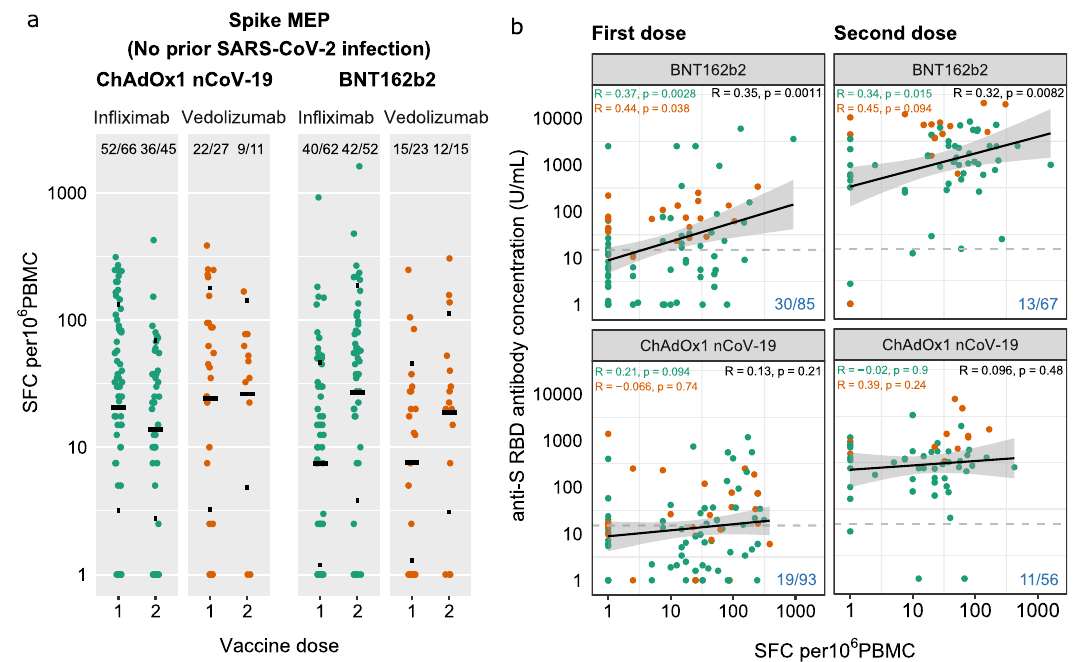
Fig. 3 Anti-SARS-CoV-2 spike T cell responses strati fi ed by vaccine platform (BNT162b2 vs ChAdOx1 nCoV-19), biologic therapy (in fl iximab vs vedolizumab) and vaccine dose (one vs two). a Spike MEP T cell responses SFC per 10 6 PBMC strati fi ed by vaccine platform, biologic therapy (in fl iximab vs vedolizumab) and the number of vaccine doses. The horizontal bar represents the geometric mean and the narrow bars represent one geometric standard deviation on either side of the geometric mean. The number of T cell responders / total number of individuals tested are shown in black at the top of each panel. b Scatterplot demonstrating the correlation between T cell responses against spike MEP pool (SFC per 10 6 PBMC) and anti-SARS-CoV-2 spike antibody concentration after the fi rst (LHS) and second (RHS) dose of BNT162B2 (top) and ChAdOx1 nCoV-19 (bottom) vaccine. The number of non-T cell responders/total number of individuals tested is shown in blue on the bottom RHS of each panel. The shaded grey band represents the 95% con fi dence interval. The horizontal dotted line in b represents a threshold of 15 U/mL of anti-S1 SARS-CoV-2 antibody. The tests were two-tailed and p values were reported without correction for multiple testing. The biologic in fl iximab is shown in green and vedolizumab is shown in orange. Source data are provided as a Source Data fi le. MEP mapped epitope peptide, SFC spot forming cells, PBMC peripheral blood mononuclear cell, LHS left-hand side, RHS right-hand side, R Spearman ’ s rank